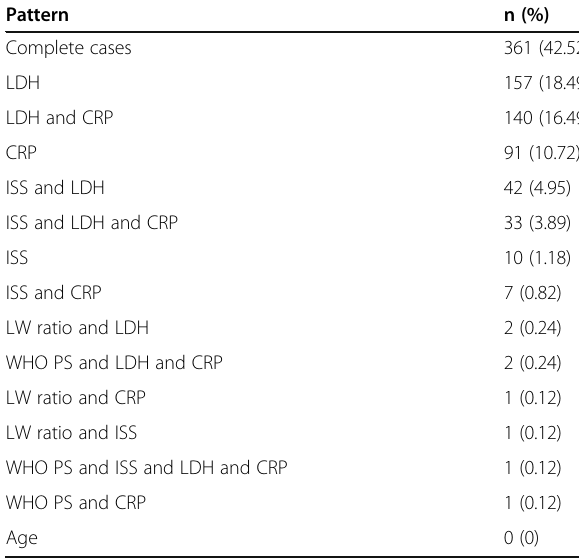
Table 3 Missing data pattern in the test dataset. The percentage of missing data for a single proposed prognostic factor within the test dataset can be calculated by summing all the patterns that include that variable Pattern n (%) Complete